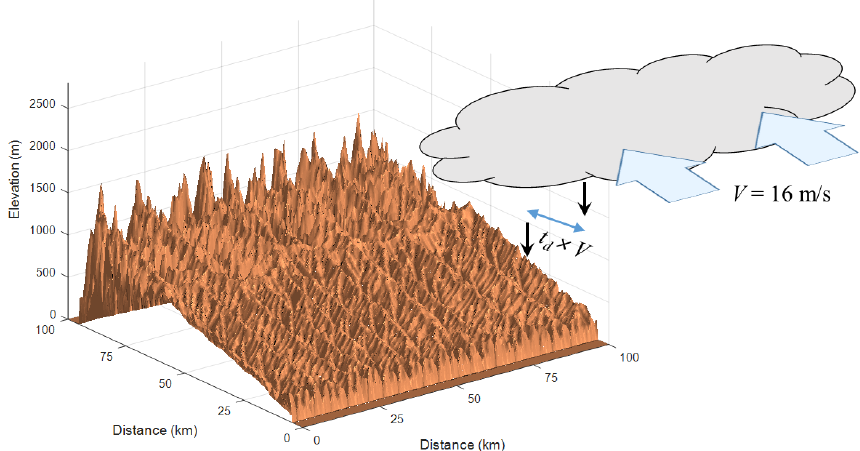
Figure 2. Schematic showing orographic rainfall over the 3D bird view of topography. Results after 5Ma from co-evolution simulations with V = 16ms − 1 and t d = 1200s are shown (transect shown in Fig. 3b). Horizontal displacement of raindrop from generation to falling location is given as t d × V